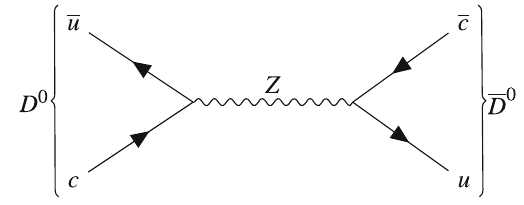
Fig. 5 NP contribution to D 0 − D 0 mixing via Z -mediated FCNC